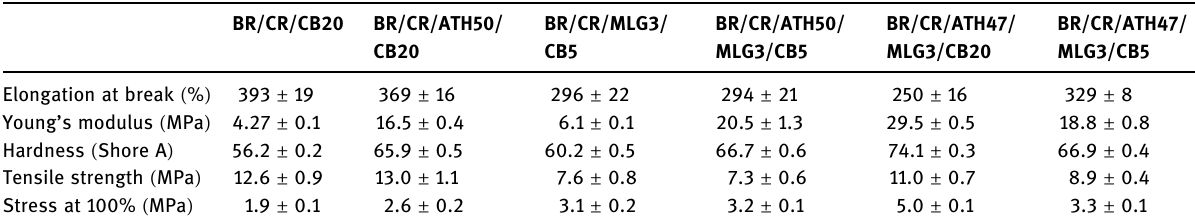
Table 3: Mechanical properties of BR/CR composites BR/CR/CB20 BR/CR/ATH50/ CB20 Elongation at break ( % )